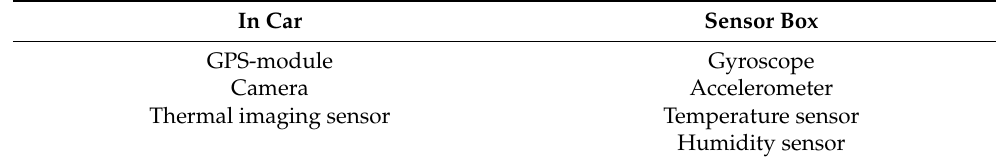
Table 1. External sensors mounted on the vehicle